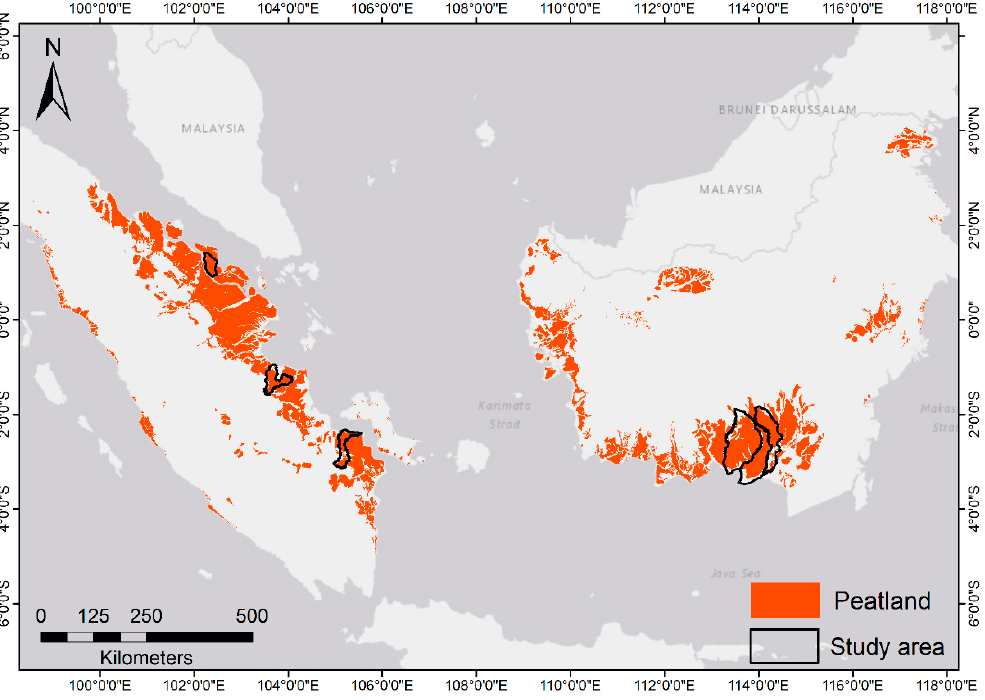
Figure 2. Overview of the known peatlands in Kalimantan and Sumatra, Indonesia (brown). In total, the Indonesian peatlands cover an area of approximately 200,000 km 2 . Black outlines indicate the six hydrological units that were investigated, which cover more than 10% (21.924 km 2 ) of the peatland area in Indonesia. Sungai Katingan Sebangau, Sungai Kahayan Sebangau, and Sungai Kahayan Kapuas (from west to east) are in Central Kalimantan, and Pulau Padang (north), Sungai Mendahara–Sungai Betanghari (center), and Sungai Saleh–Sungai Sugihan (south) are located on Sumatra.